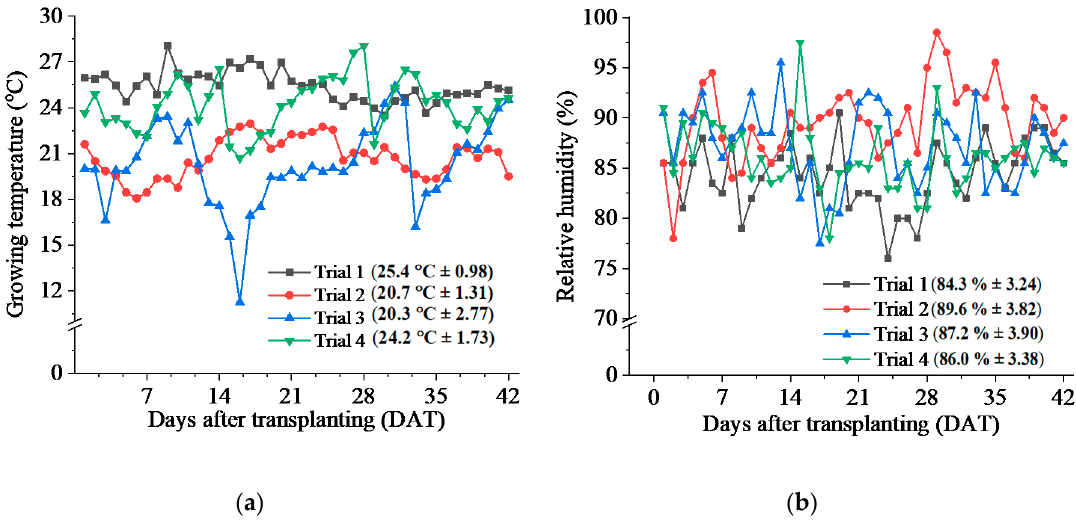
Figure 3. The growing environment conditions within the experimental greenhouse. ( a ) The average greenhouse temperature recorded in each trial; ( b ) The average relative humidity recorded in each trial. Values in parentheses are mean ± SD (n = 24).